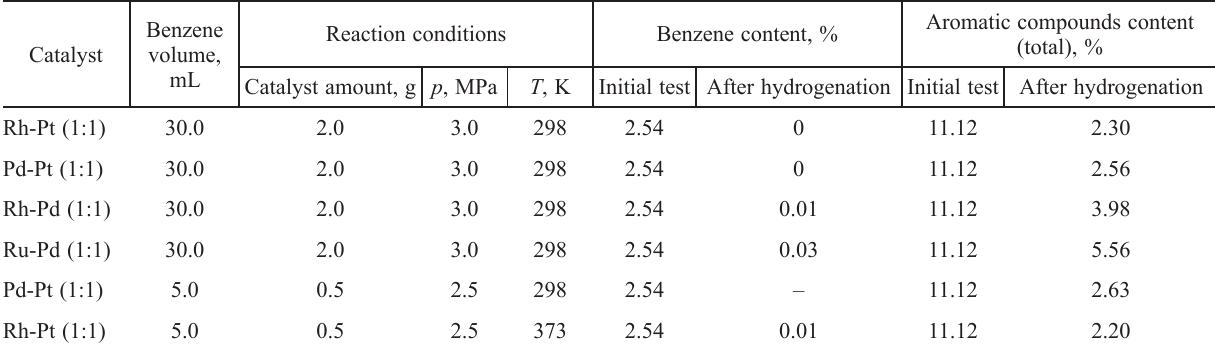
Table 2 – Hydrogenation of the gasoline fraction “hydrogenate” pos.11-SN-002 KU GBD on the bimetallic catalysts, supported on Al O 2 3 Catalyst